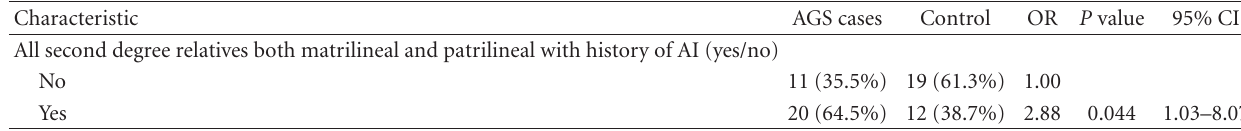
Table 2: History of autoimmune disease in second degree relatives of cases and